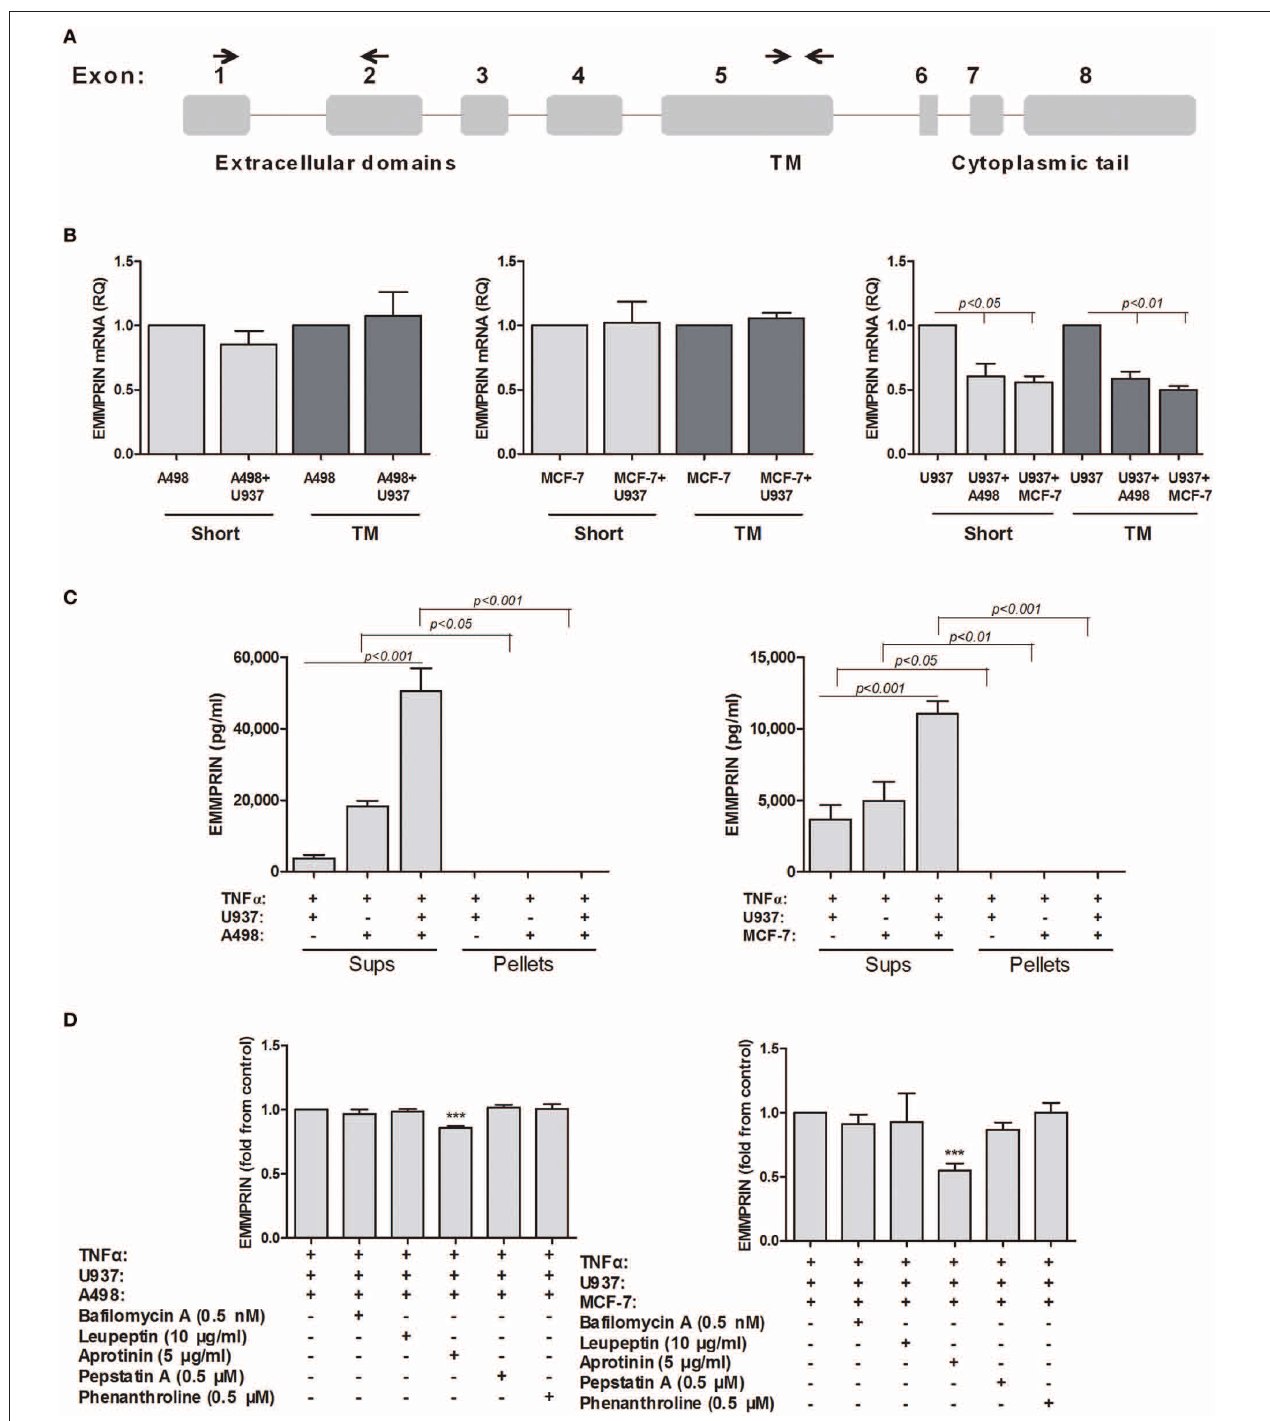
FIGURE 3 | Possible mechanisms for generating secreted EMMPRIN protein. 10 6 A498 or MCF-7 cells were incubated in single- or co-cultures with 0 . 5 × 10 6 U937 cells in the presence of TNF α (1ng/ml) for 48h. (A) A schematic representation of the different exons of the EMMPRIN mRNA. The primers used for the amplification of the transmembranal (TM) or extracellular regions of the short isoform are indicated by small arrows. (B) Total RNA was extracted and transcribed into cDNA. Amplification of both the